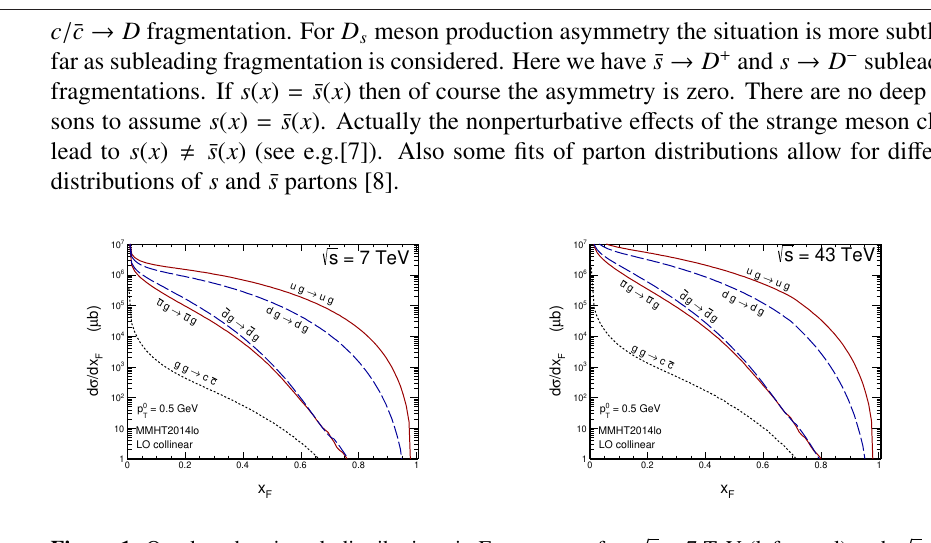
Figure 1. Quark and antiquark distributions in Feynman x F for TeV (right panel) corresponding to E lab ( p ) = 10 9 GeV. This calculation was performed within collinear- factorization approach with somewhat arbitrary regularization parameter p 0